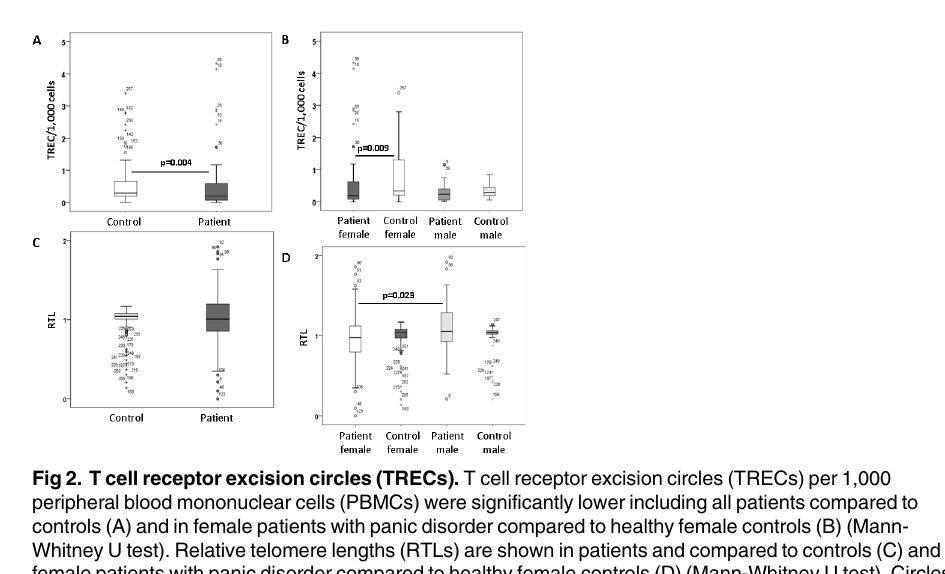
independent factor for lower TRECs, whereas gender (p = 0.162), smoking (p = 0.727), and comorbid depression (p = 0.925) or antidepressants (p = 0.483) had no significant association.